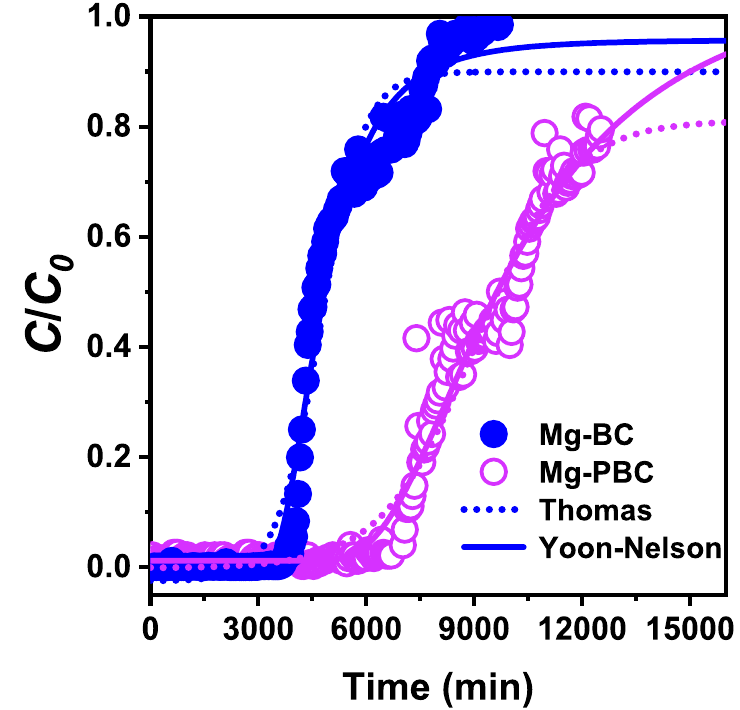
Fig. 5 Dynamic adsorption data fitted to the Thomas and Yoon-Nelson model